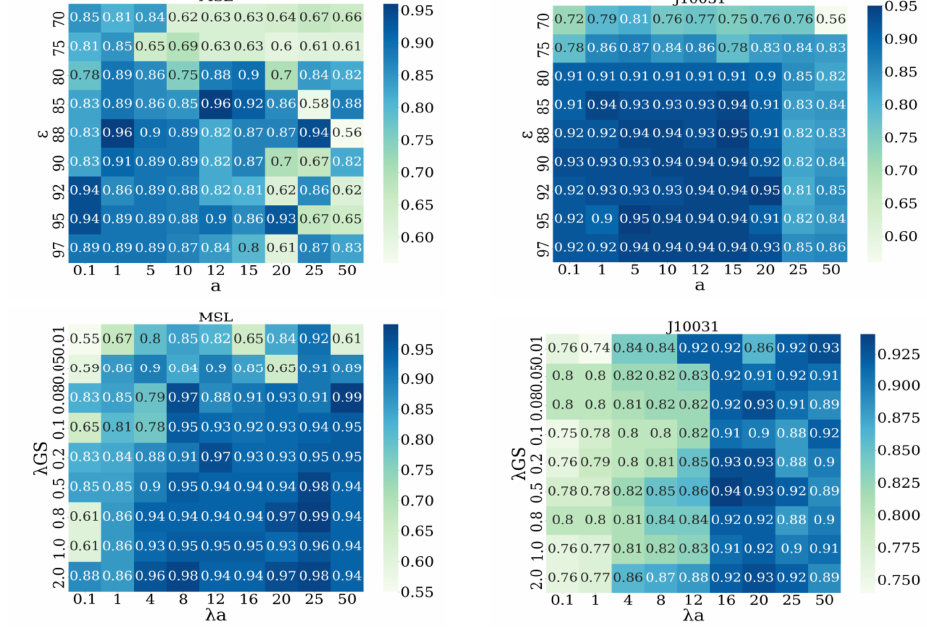
Figure 8. Performance comparison between heat map distributions for different